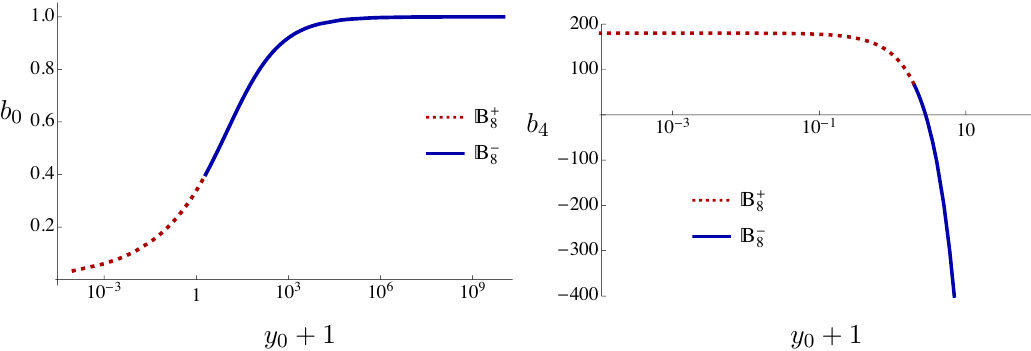
Figure 4 . Values of the UV parameters b 0 (left) and b 4 (right) from the numerical integration.